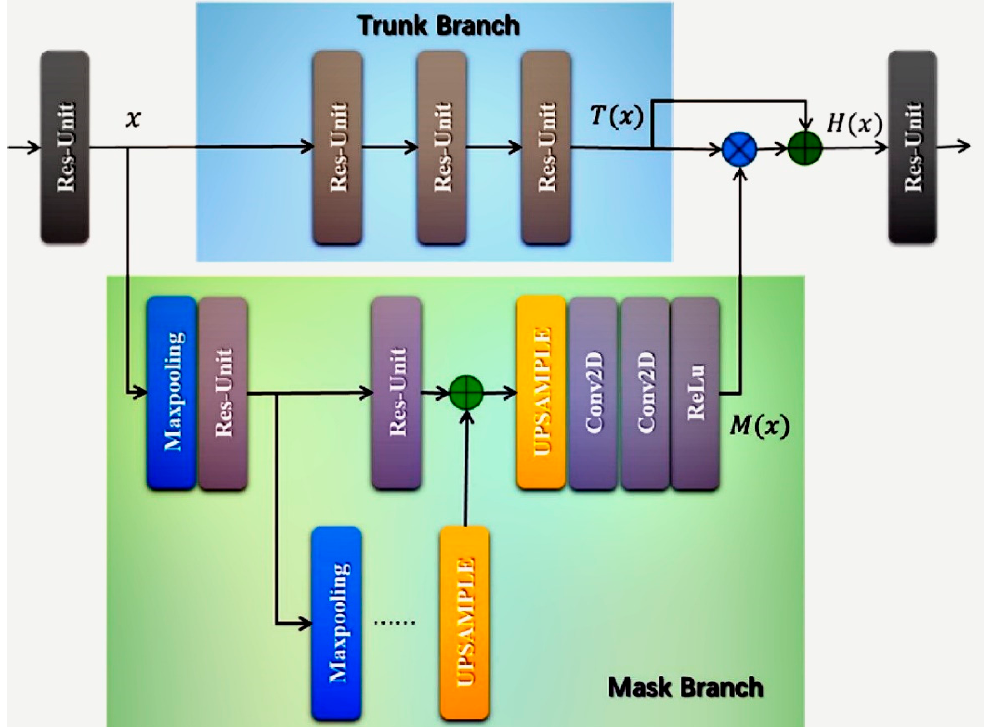
Figure 5. Attention gate architecture. The gradient from the background region decreases in weight when traveling backwards.